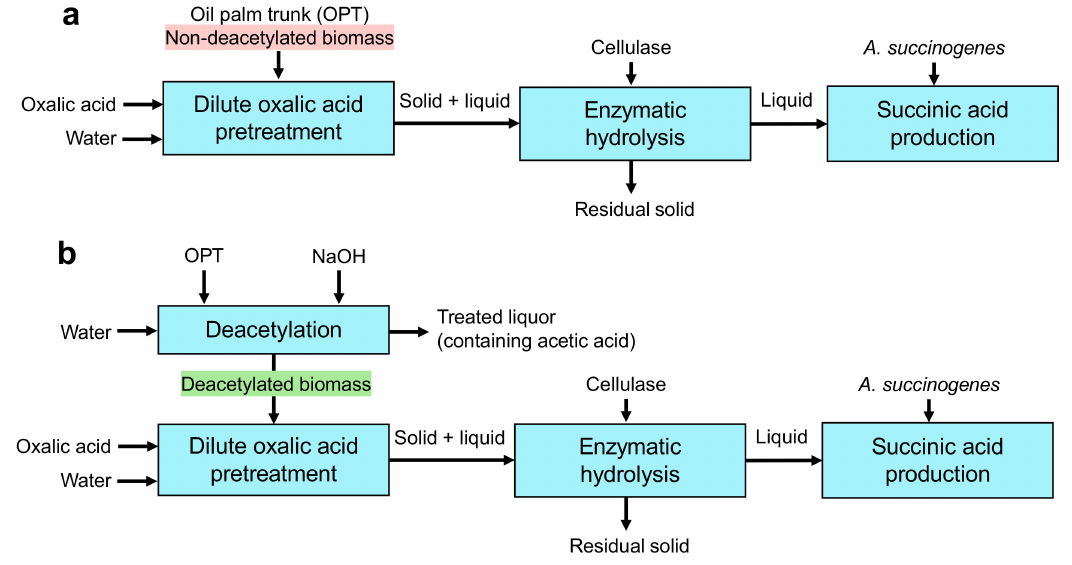
Figure 1. Diagram of the process used to produce succinic acid in this study. Hydrolysate from oil palm trunk (OPT) was produced from two different configurations: ( a ) only dilute oxalic acid pretreatment (DOAP) is applied prior to enzymatic hydrolysis and succinic acid fermentation, and ( b ) deacetylation step is introduced prior to DOAP, followed by enzymatic hydrolysis and succinic acid